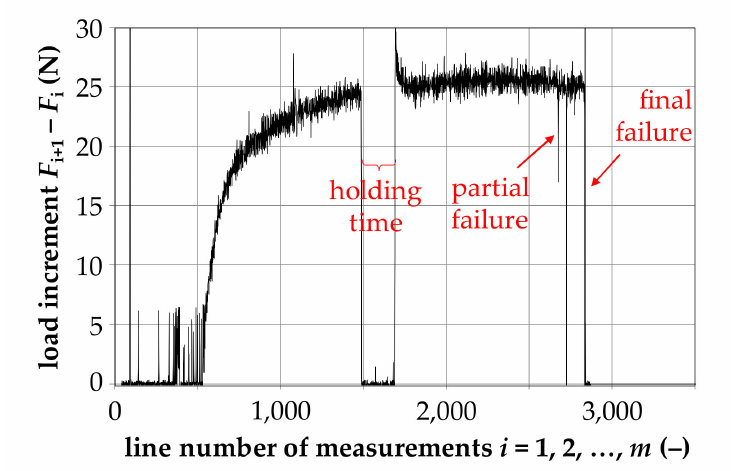
Figure 6. Example for the detection of potential partial failure(s) and/or sudden release of internal